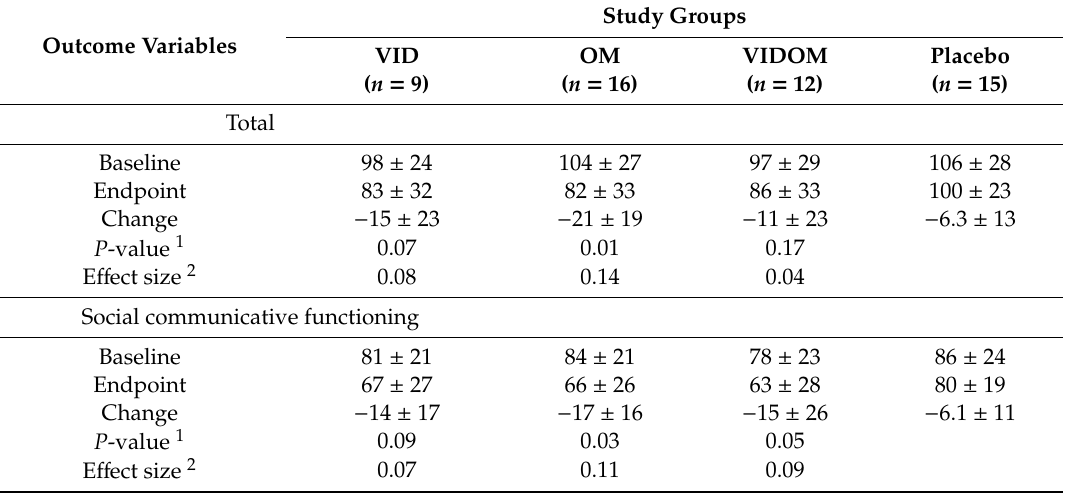
Table 4. Core symptoms of ASD assessed using the Social Responsiveness Scale (SRS) among children whose IL-1 β was elevated (IL-1 β ≥ 3.2 pg / mL) and who completed the study across treatment groups ( n =